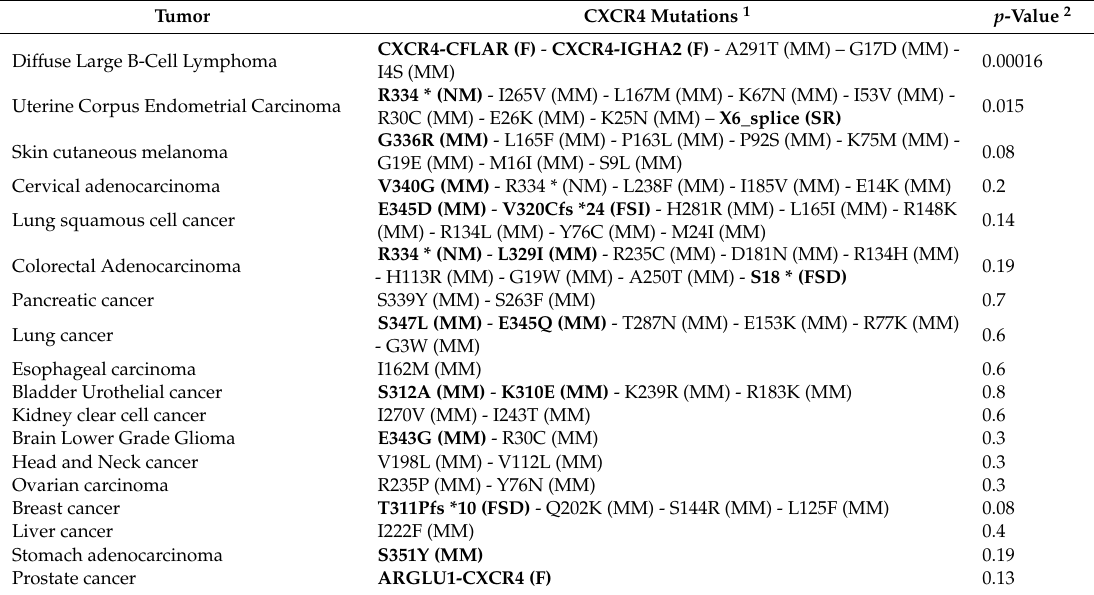
Table 1. The Cancer Genome Atlas (TCGA) screening for CXCR4 mutations in